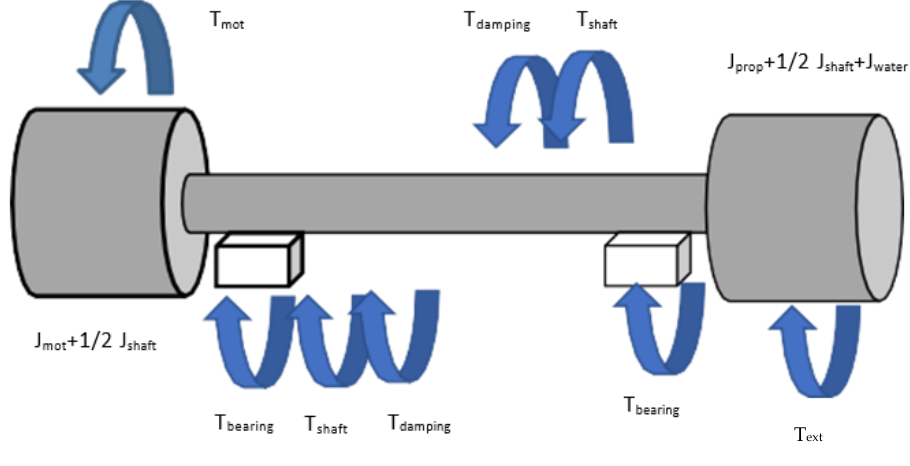
Figure 10. Shaft dynamics diagram.